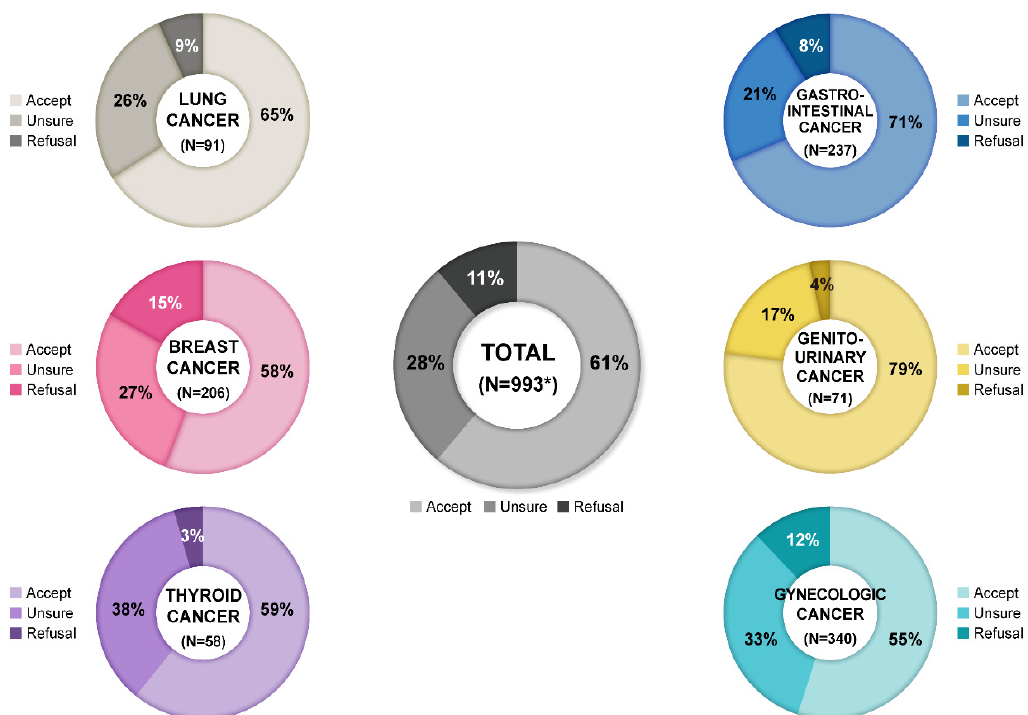
Figure 2. Patients’ intention to take COVID-19 vaccination according to the major malignancy types. * Total number is not the sum of cancer types, since duplication is allowed.